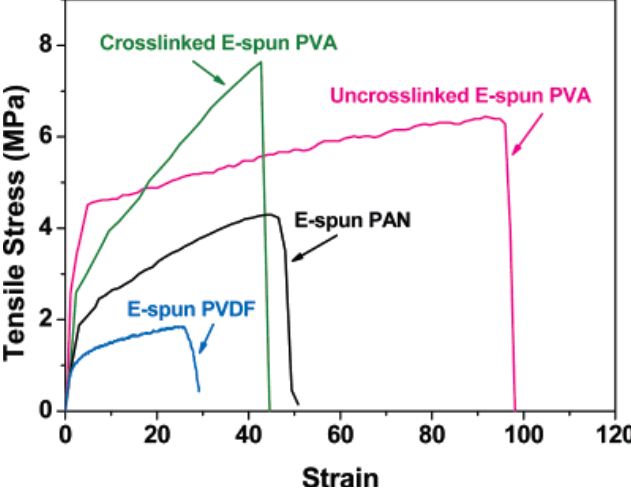
Figure 6. Tensile stress and strain curves of electrospun nanofibrous substrates (Adapted from